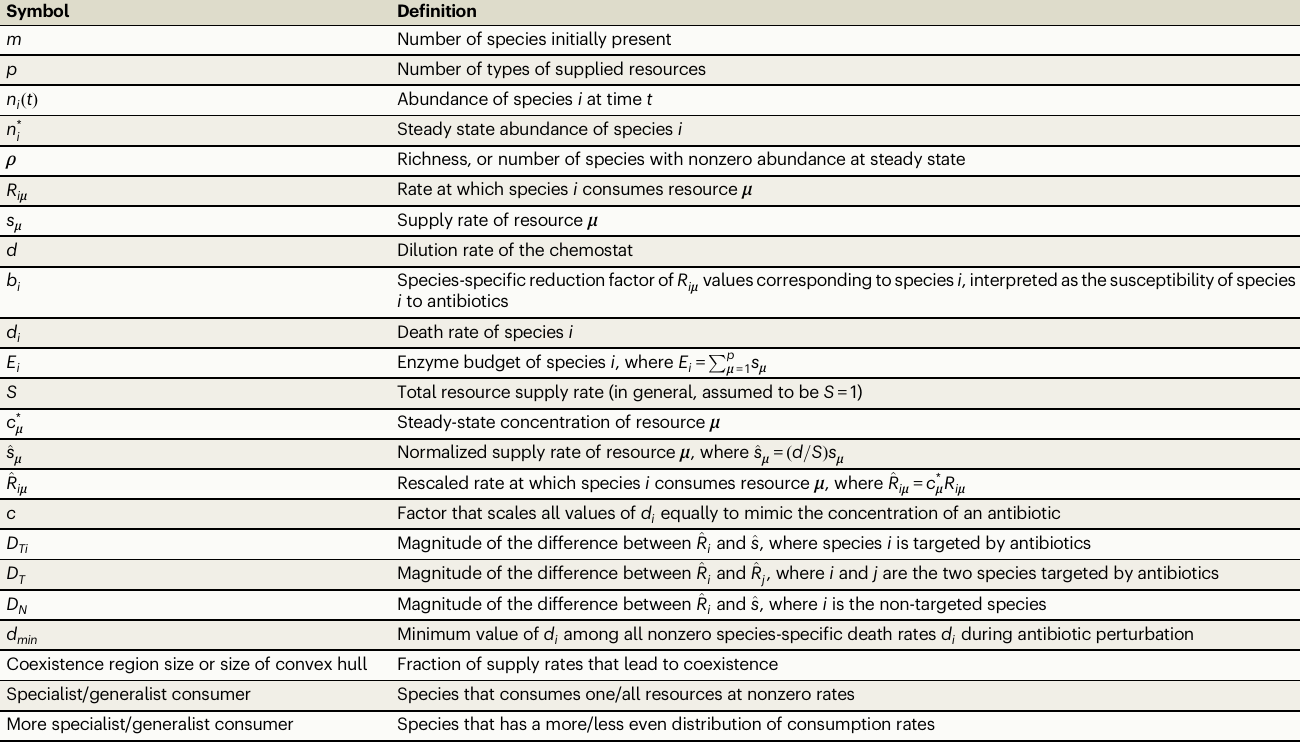
Table 1 | De fi nitions of key variables and terms